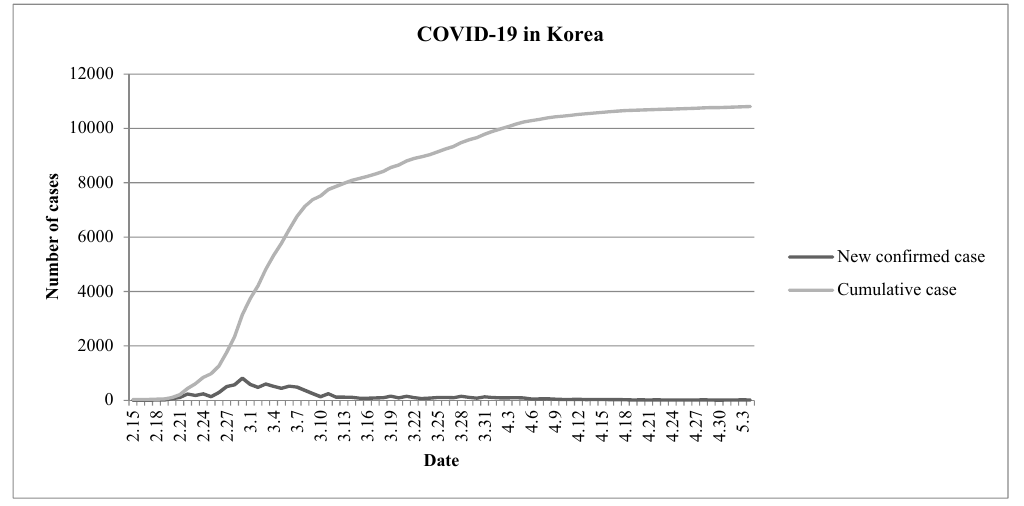
Figure 1. Changes in the number of COVID-19 patients in Korea (15 February–4 May 2020).